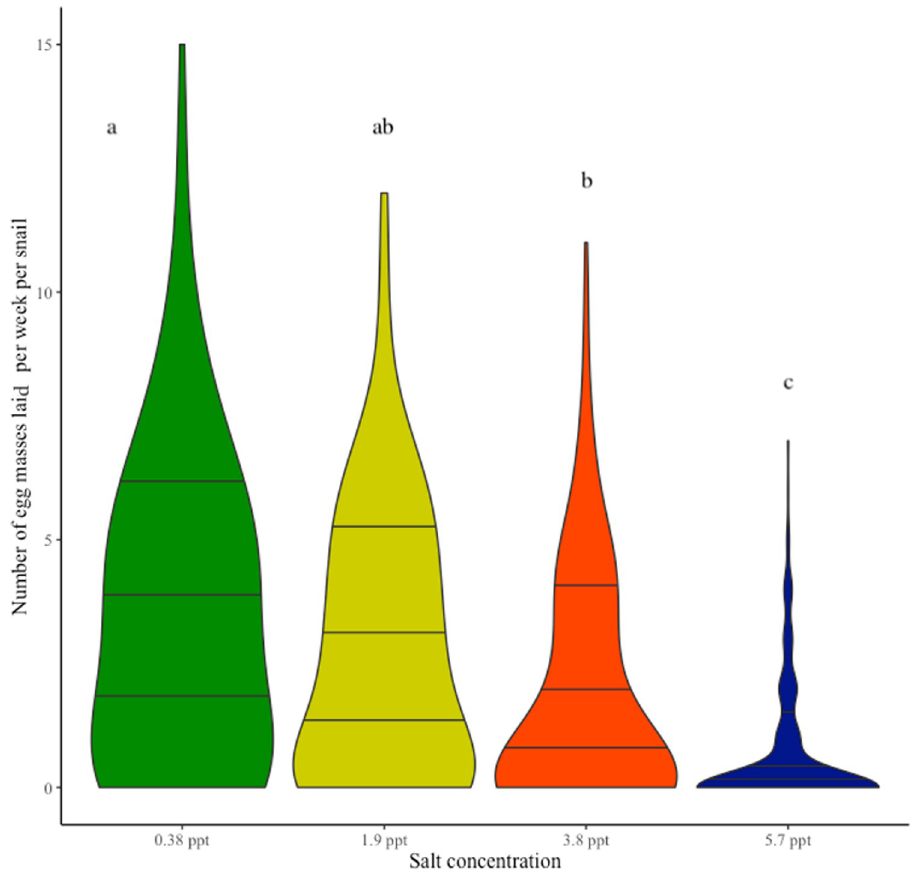
Fig 2. Egg mass output for uninfected snails in treatment groups 0.38 ppt, 1.9 ppt, 3.8 ppt, and 5.7 ppt. The sample size for uninfected snails are 18 snails in 0.38 ppt with 144 total observations, 47 snails in 1.9 ppt with 376 total observations, 33 snails in 3.8 ppt with 264 total observations, and 39 snails in 5.7 ppt with 312 total observations. Snails in the 0.38 ppt salinity treatment had significantly higher egg mass output than 3.8 ppt (p < 0.05) or 5.7 ppt (p < 0.0001). Snails in the 1.9 ppt and 3.8 ppt treatments also had a higher output compared to the 5.7 ppt treatment (p < 0.0001 and p < 0.05, respectively). The horizontal lines on the violin plot represent data quantiles of 25%, 50%, and 75%. Letters above bars indicate significant differences in egg mass production, with different letters representing significant differences. For pairwise comparisons see supplement Table C in S1 Text .